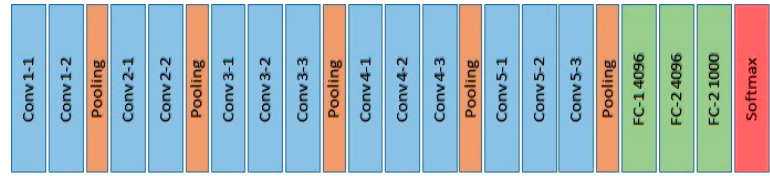
Figure 4. VGG-16 architecture. The VGG-16 model consists of 5 Convolution layers (in blue) each is followed by a pooling layer (in orange), and 3 fully-connected layers (in green), then a final Softmax classifier (in red).